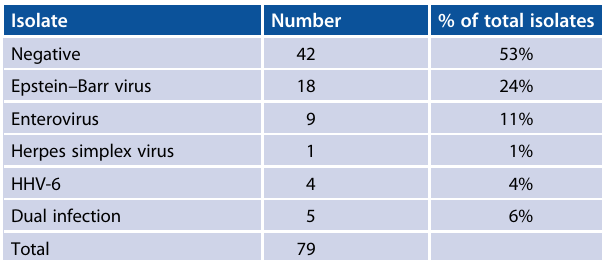
Table 1: Aetiology of viral meningitis Isolate